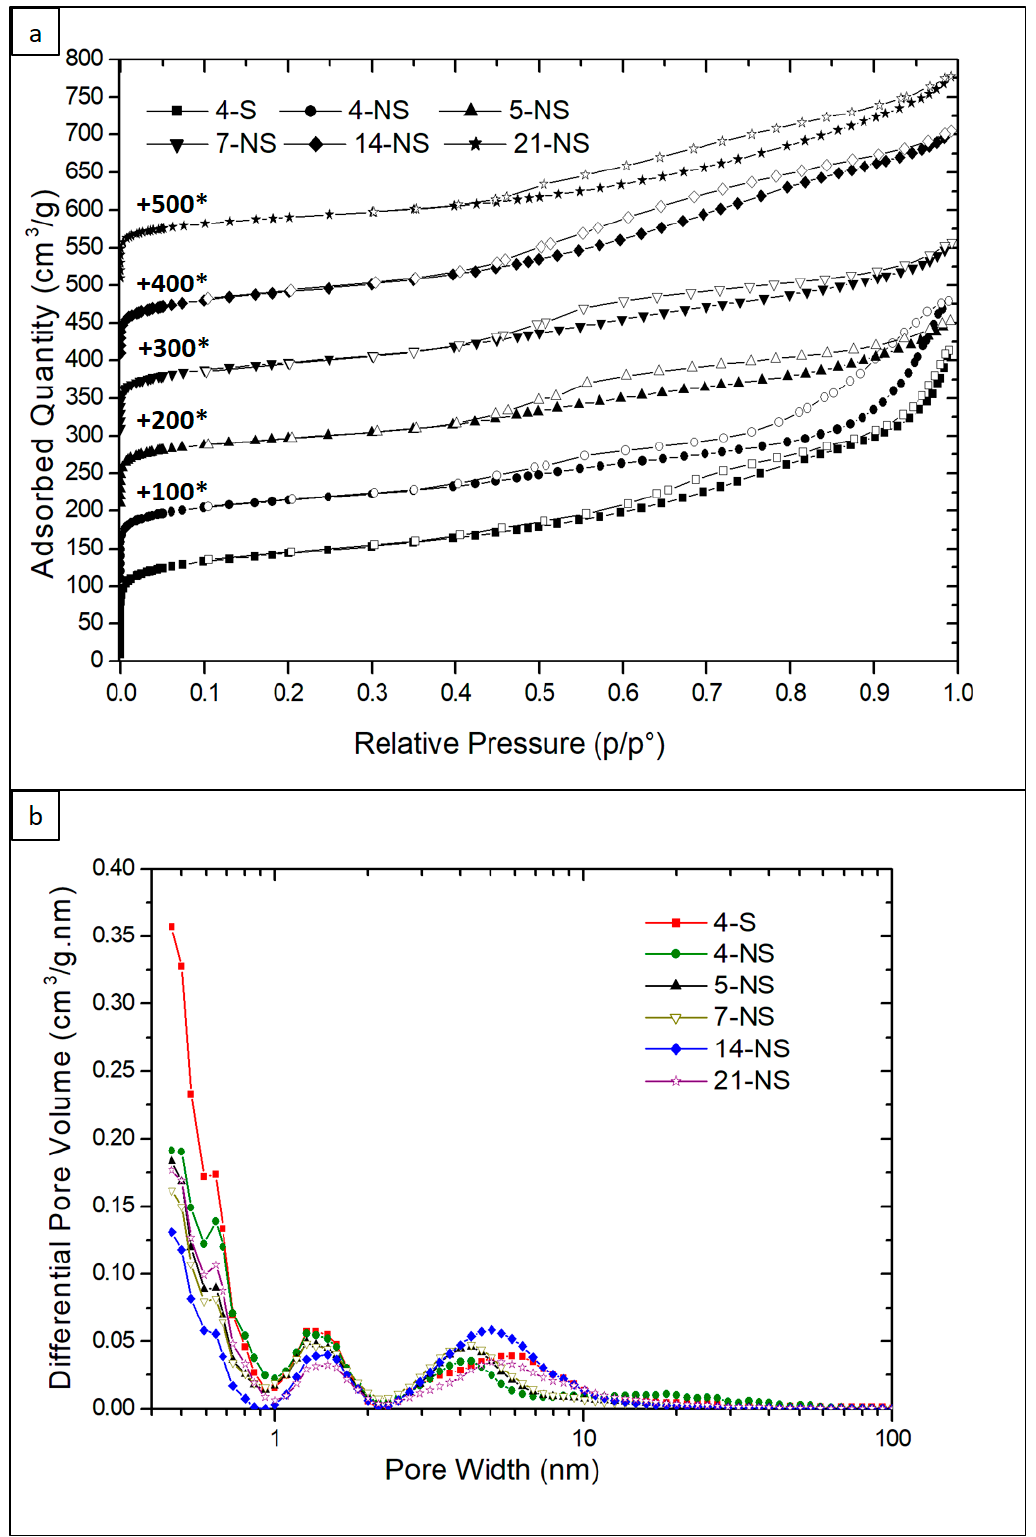
Figure 4. ( a ) N 2 isotherms sorption at 77 K and ( b ) pore size distributions for all the calcined samples obtained after pseudomorphic transformation. (*) For clarity reason, isotherms have been shifted along y -axis and these values (in cm 3 /g) are the used increments.